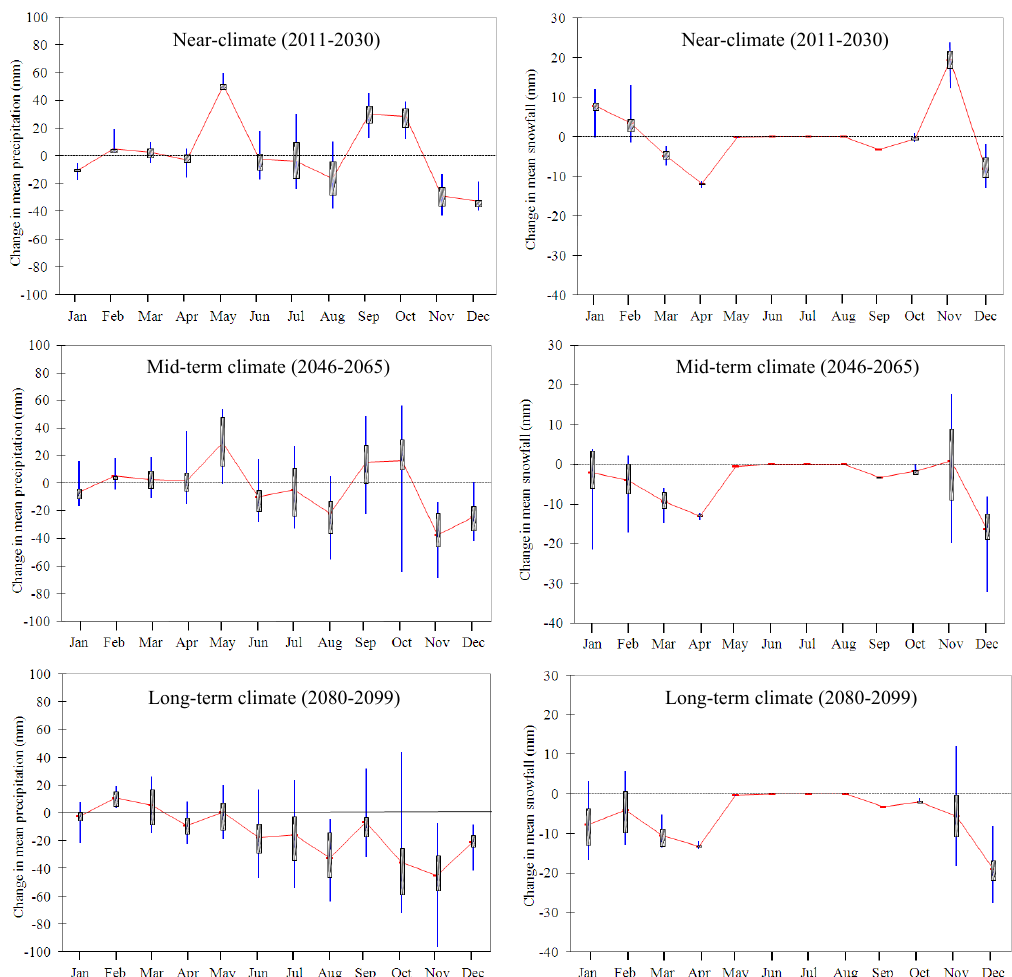
Fig. 8. Change in monthly precipitation and snowfall compared to the baseline time period. The box-plots represent interquartile ranges for the 25th and 75th percentiles from all 10 scenarios. The solid line represents the average of 10 scenarios.